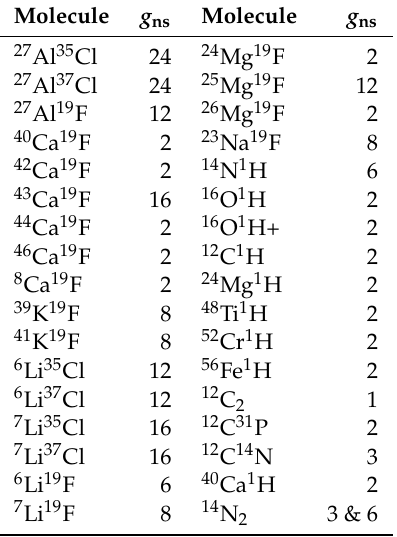
Table 4. Statistical weights used to convert the partition functions by Sauval and Tatum [23] to ExoMol. Molecule g ns Molecule g